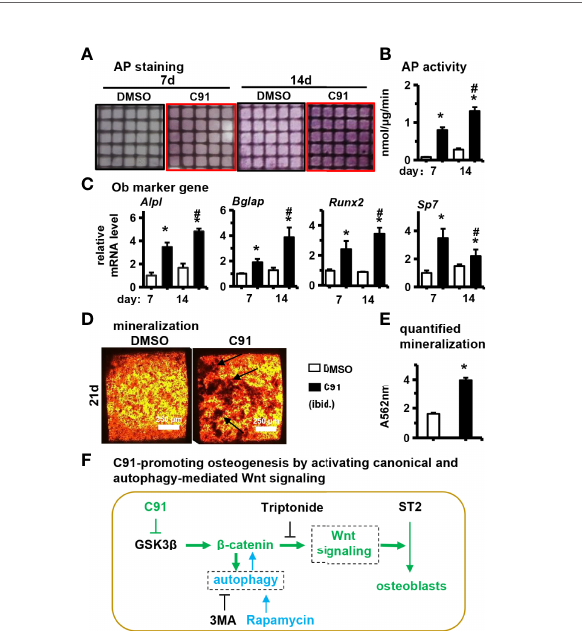
FIGURE 8 | Effects of C91 on ST2 cell differentiation and mineralization in 3D modules. 3D modules were cultured in complete medium for 2 days and then switched to osteogenic induction medium. The medium was changed in half every two days. After 7 and 14 days of culture, AP staining (A) analysis and AP biochemical quanti fi cation (B) analysis were performed. (C) qRT-PCR detection of the effect of C91 in the 3D module on the expression of osteogenic target genes in ST2 cells. (D) 3D modules were induced to mineralize for 21 days, followed by Alizarin Red S staining to detect mineralized nodules. Black arrows indicate mineralized nodules. Scale bar = 50 m m. (E) is the quantitative analysis result of panel (D, F) C91-promoting osteogenesis by activating canonical and autophagy-mediated Wnt signaling. *Indicates P <0.05, compared to the 7-day DMSO group. # indicates P <0.05, compared with the 14-day DMSO